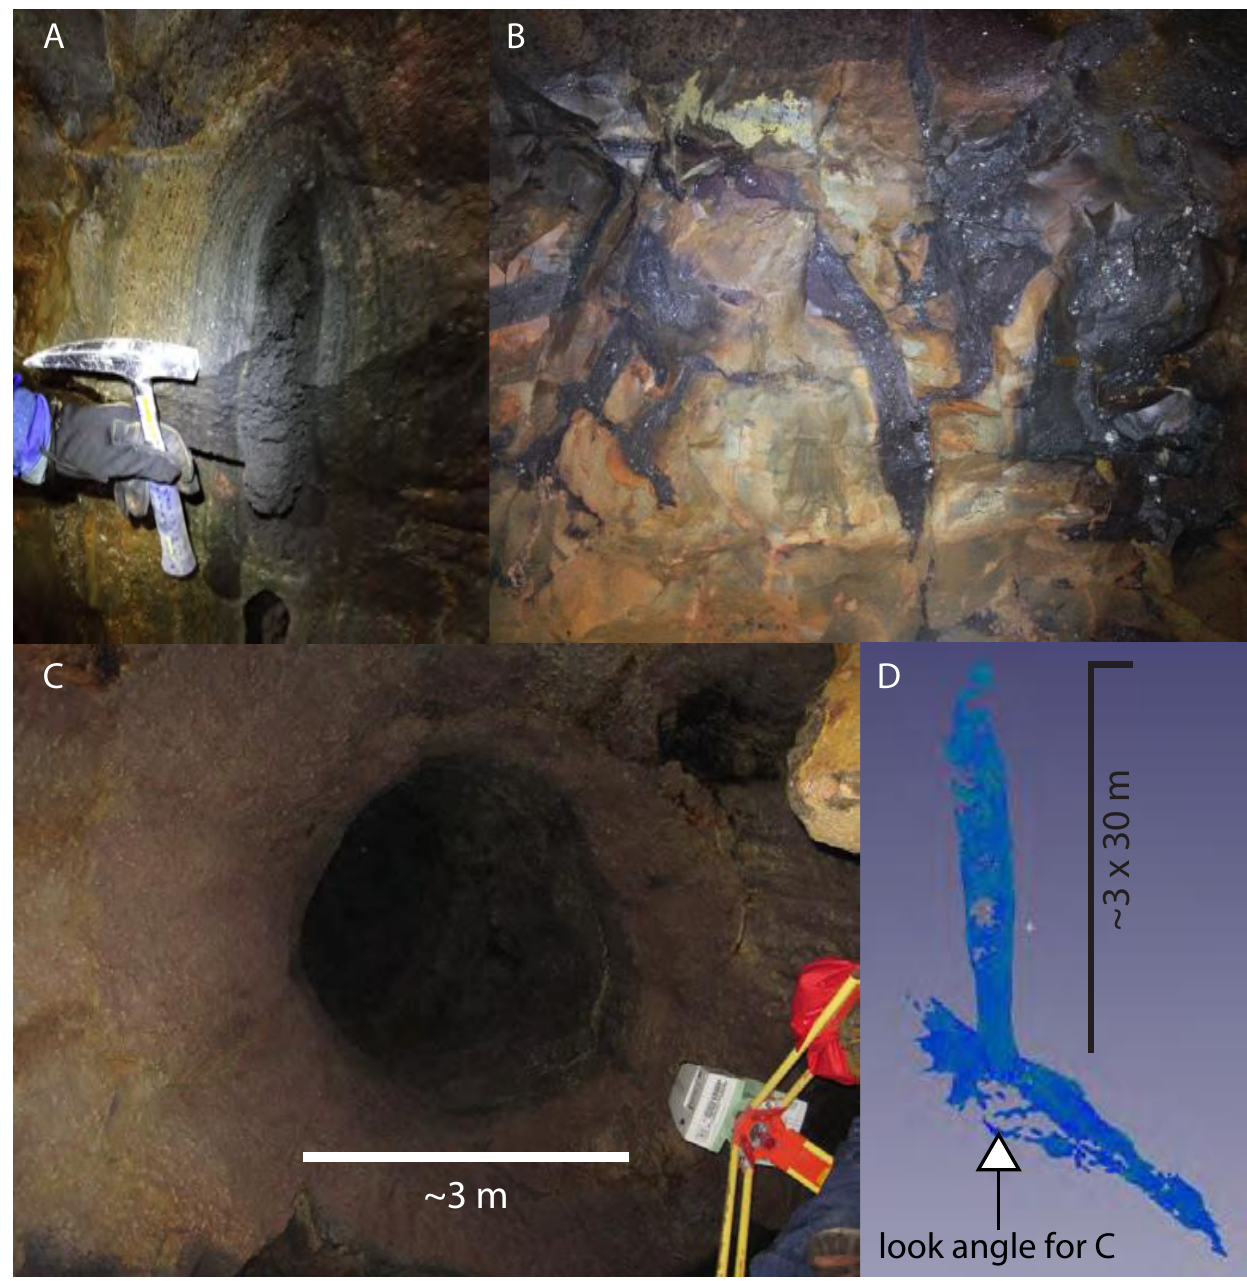
Figure 6: [A] A large vesicle captures annular gas flow through the conduit system. [B] Small irregular intrusions several cm wide and ~20 cm long infiltrate a rare, well consolidated (possibly by alteration) section of tephra in the cave, illustrating how less well consolidated tephra was likely to have been intruded and incorporated into the ascending magma. This exposure occurs in the center of the main dike in the narrow crawl space descending into the deepest part of the south end of the cave (Figure 3B) near where a 3-meter-wide cylindrical conduit [C] is exposed. LiDAR images [D] show that it extends vertically 30 meters upward within the plane of the main feeder